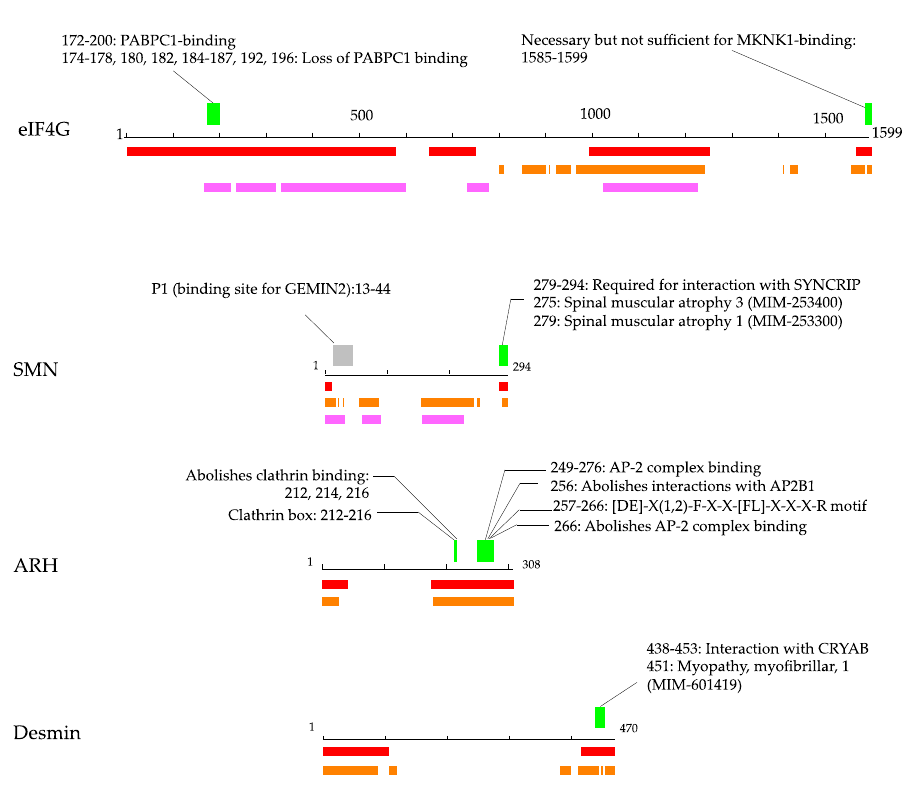
Figure 3. Examples of proteins with pProS. The black line in the middle represents the amino acid chain, and the IDR predictions are presented below. Pink, orange, and red represent the results by MobiDB-lite, DISOPRED3, and DICHOT, respectively. The green bars represent pProSs, and the annotations defining pProS are shown above with the residue numbers of the annotations. The gray bar in the example of survival of motor neuron (SMN) represents the regions of a pseudo-pProS, which was not taken as pProS because the region of the annotation is longer than 30. In the case of low-density lipoprotein receptor adaptor protein 1 (ARH) and desmin, MobiDB-lite does not predict any IDRs. The scale of eIF4G1 (eukaryotic translation initiation factor 4 gamma 1) differs from other three.